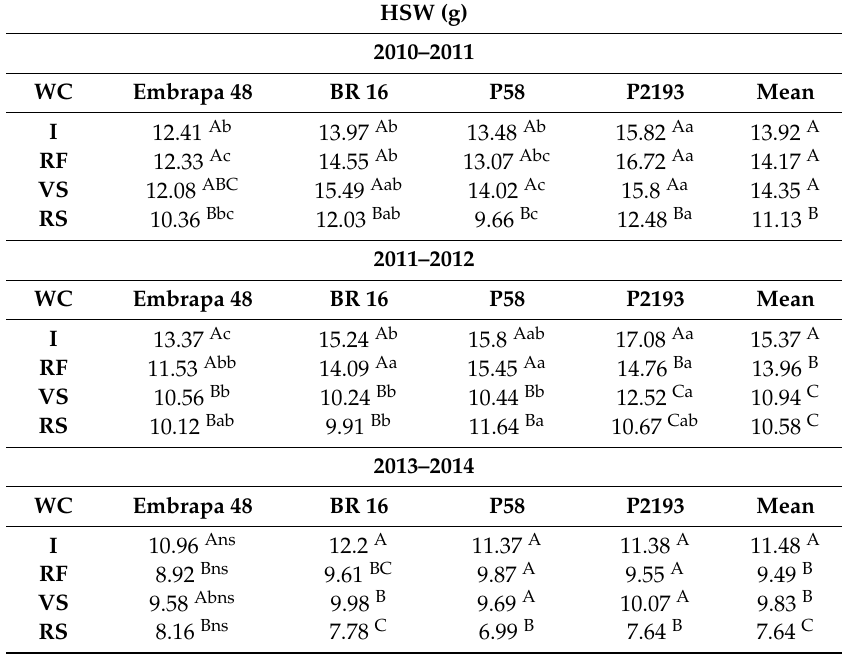
Table 2. Dry weight (g) of 100 seeds (HSW) in soybean genotypes grown under different water conditions (WC) over three crop seasons in Londrina, PR, Brazil. HSW (g)